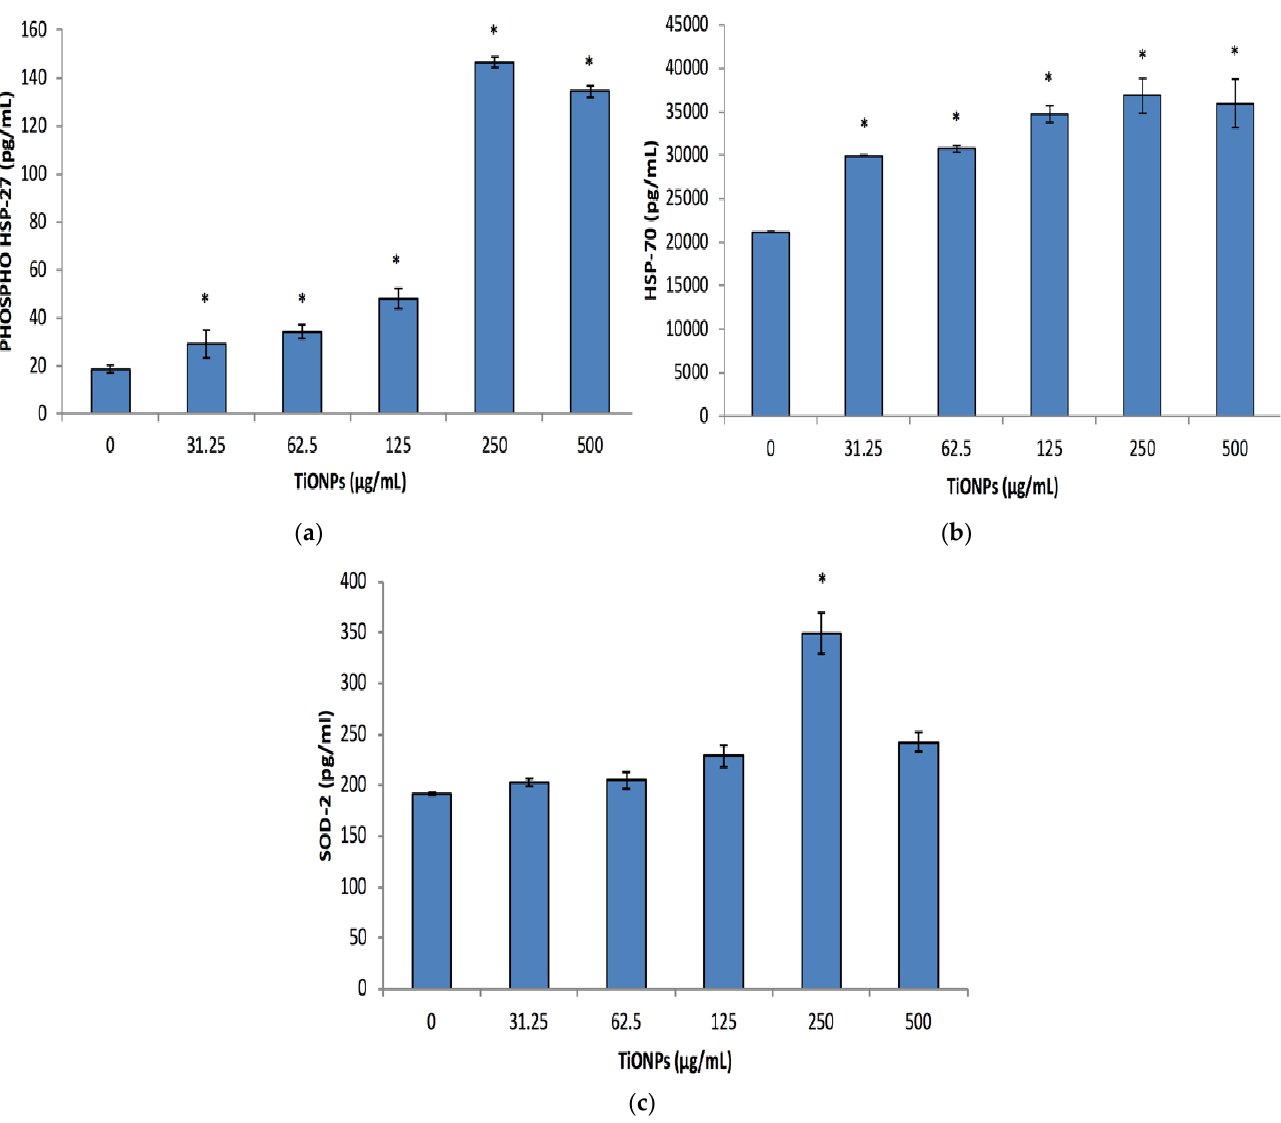
Figure 5. Phospho-HSP-27, HSP-70 and SOD-2 ( a – c ) respectively cell stress biomarkers after exposing Caco-2 cells to various TiO 2 NPs, concentrations for 48 h. Data represented as mean ± SD. Significance demarcated by (*), indicating a significant difference of p < 0.001.